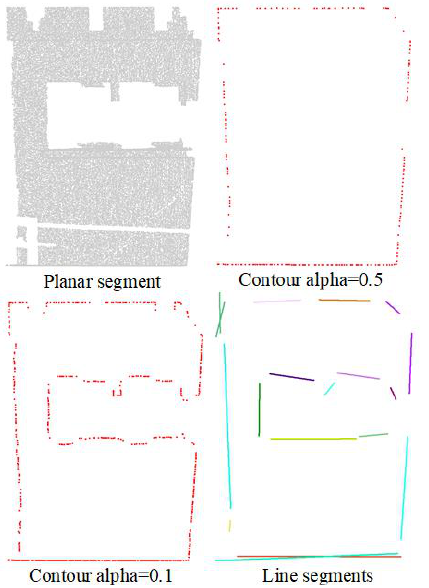
Figure 3. (a) Points of a planar segment. (b) and (c) Extracted contours with different alpha values.(d) Fitted line segments.